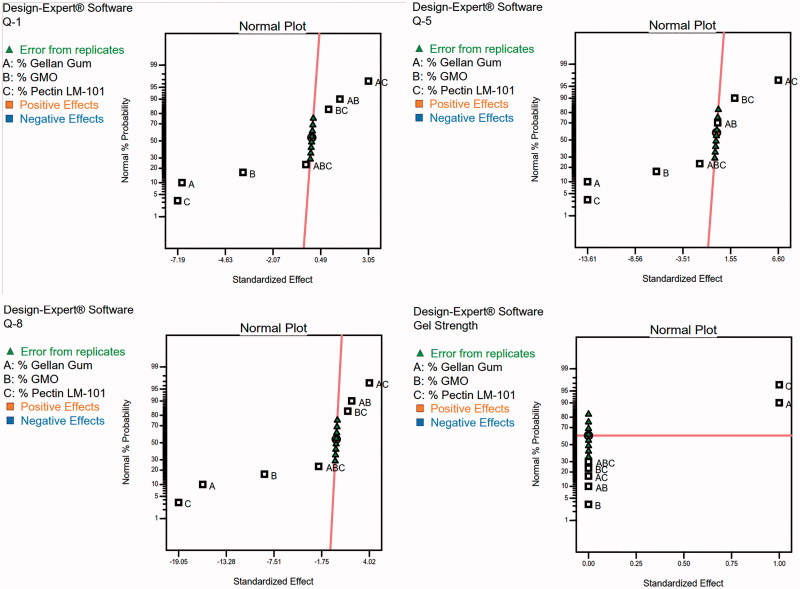
Normal plot of GBP raft formulae for screening of the influence of the studied factors.